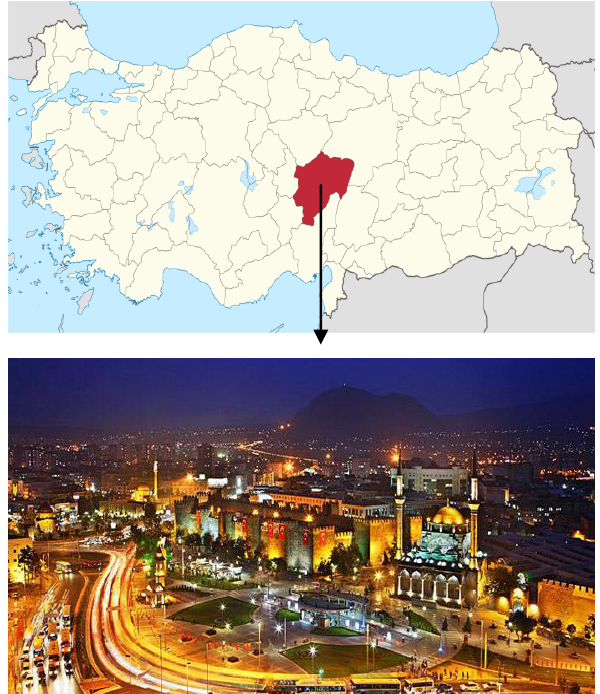
Figure 1 and 2: A map indicating the location of Kayseri and a photograph of the study area